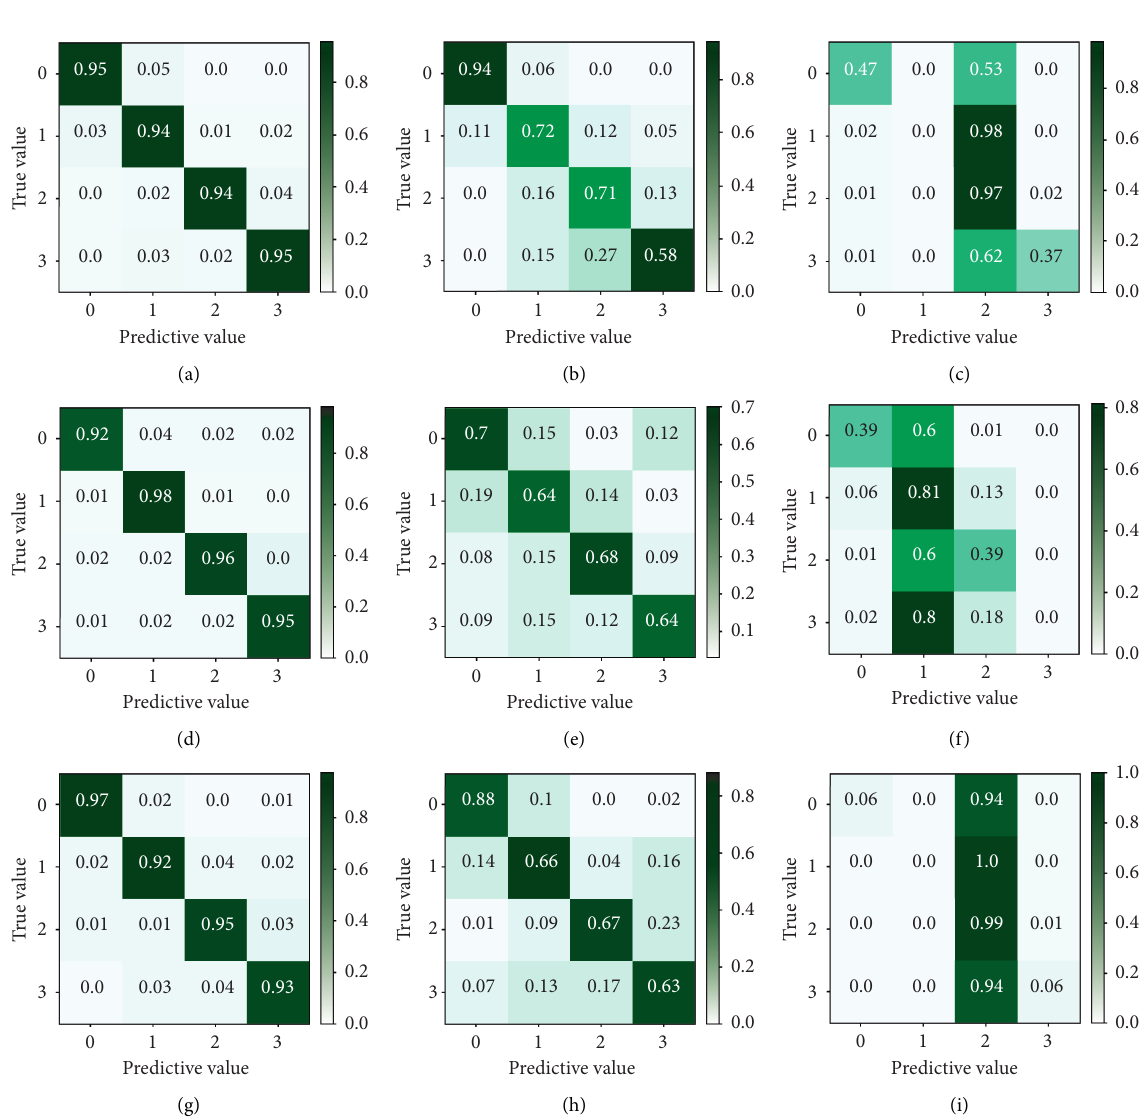
Figure 5: Multiclass confusion matrices in simulation verification. (a) Slight fault diagnosis based on RFs. (b) Slight fault diagnosis based on CART. (c) Slight fault diagnosis based on SVM. (d) Moderate fault diagnosis based on RFs. (e) Moderate fault diagnosis based on CART. (f) Moderate fault diagnosis based on SVM. (g) Severe fault diagnosis based on RFs. (h) Severe fault diagnosis based on CART. (i) Severe fault diagnosis based on